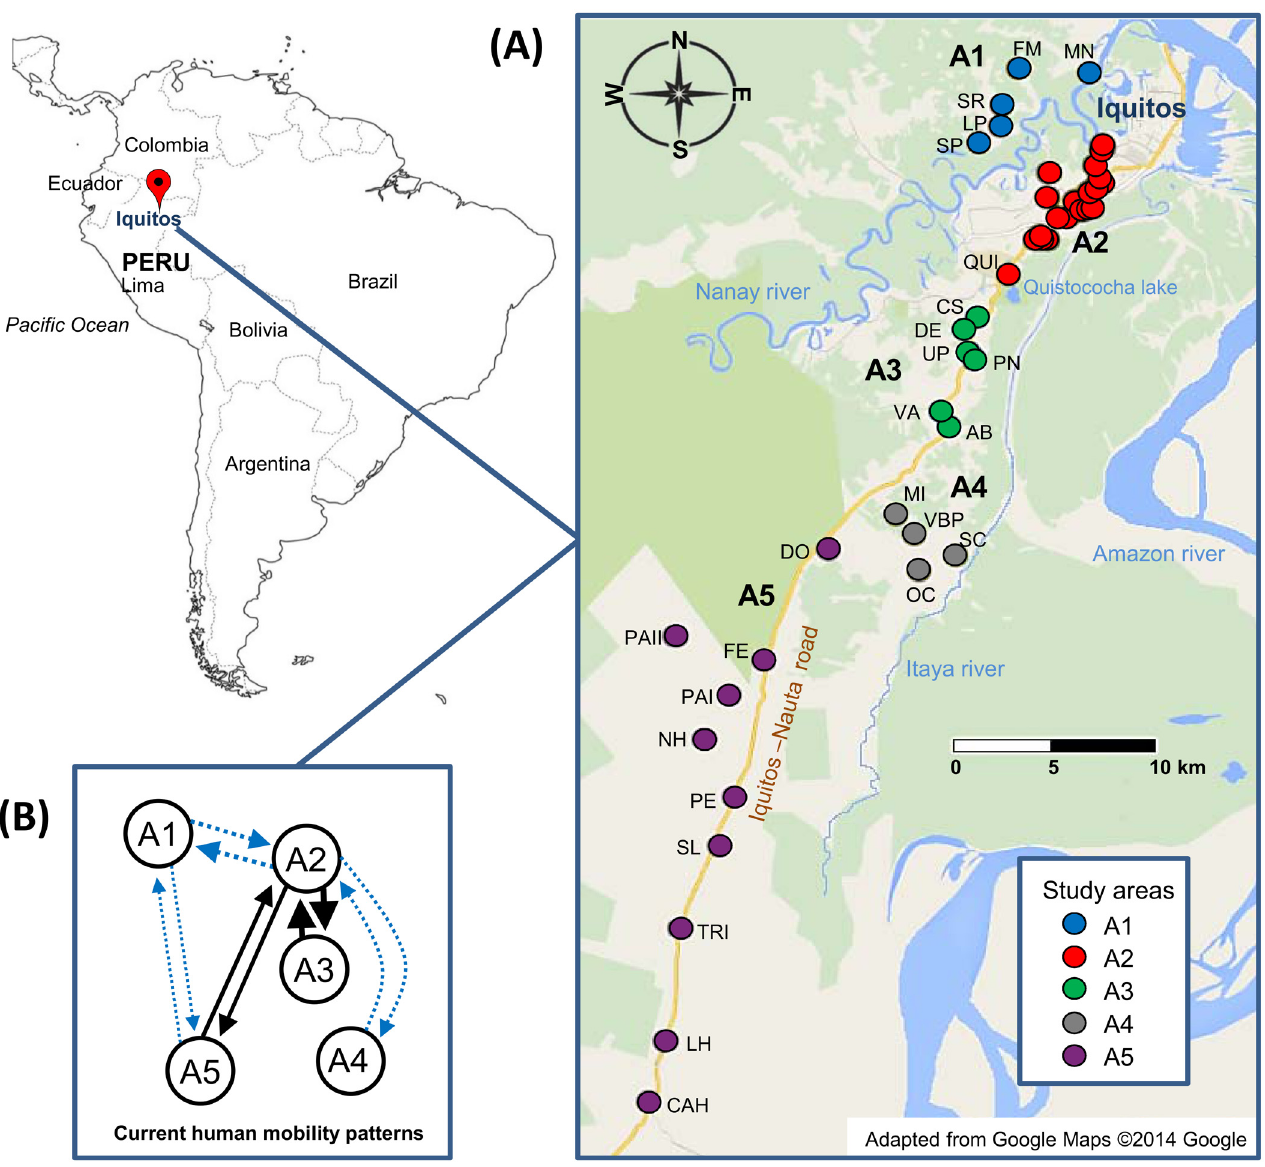
Fig 1. Study areas and human migration patterns in and around Iquitos city and along the Iquitos-Nauta road (Loreto, Peru). ( A ) Number of genotyped P . vivax isolates per area. Overall = 292: A1 = 105 (36.0%), A2 = 70 (24.0%), A3 = 32 (11.0%), A4 = 55 (18.8%) and A5 = 30 (10.3%). For detailed information of the villages that compose each area and frequency of isolates, see S1 Table. ( B ) The current human migration patterns are described by arrows indicating the direction and the occurrence of transit (thickness). Dotted blue arrows indicate that the transit involves crossing and/or navigating through a river while the solid black arrows indicate transit through the Iquitos Nauta